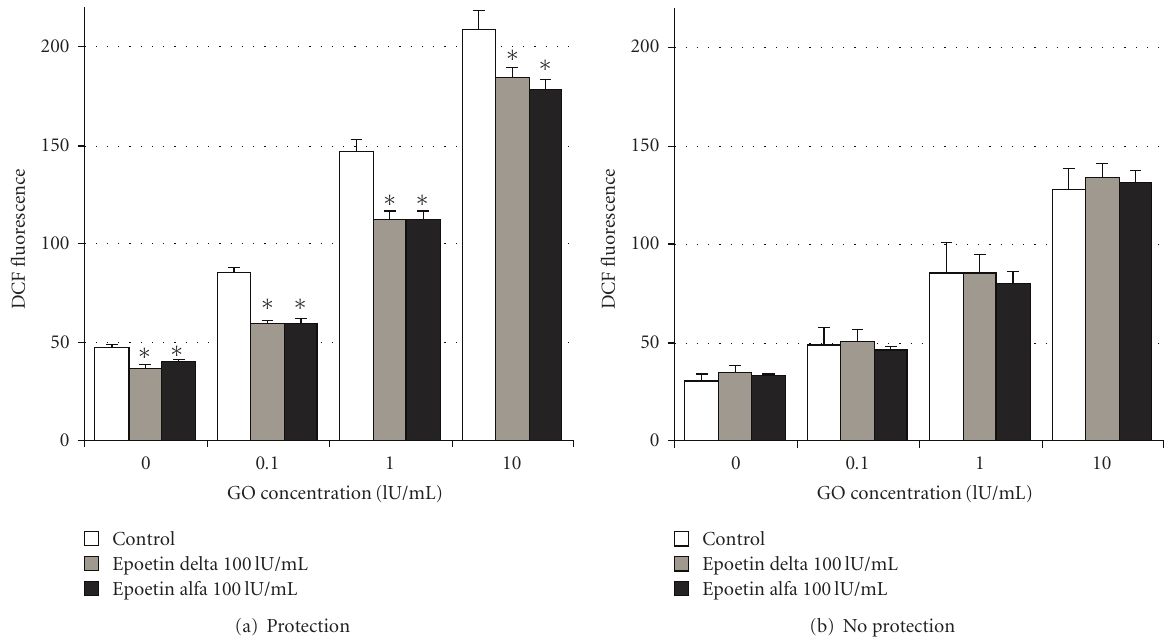
Figure 3: Comparison of epoetin delta- and epoetin alfa-induced e ff ects on GO-induced oxidative stress (240 minutes) in cell cultures originating from two di ff erent kidney specimens, one showing EPO-induced anti-oxidative e ff ects (a) and one where neither epoetin delta nor epoetin alfa had any e ff ect on oxidative stress (b). Both ESA’s showed a similar e ff ect on GO-induced oxidative stress: either they were both able to reduce the amount of ROS formed or not. The data are expressed as the mean ± SD of 4 monolayers per condition from a single experiment representative of 2 separate experiments. ∗ P < . 05 compared to the control.